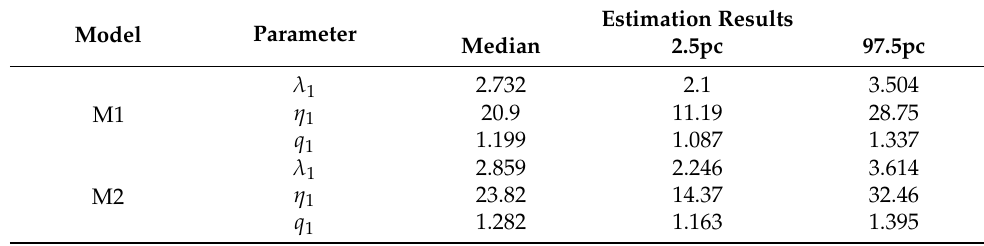
Table 3. Parameter estimation